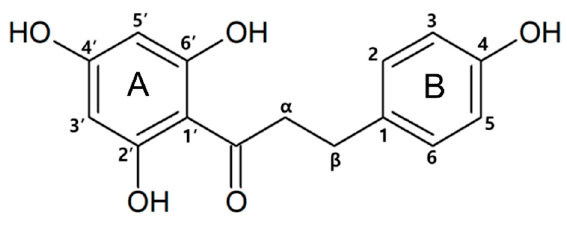
Figure 1. Chemical structure of phloretin.